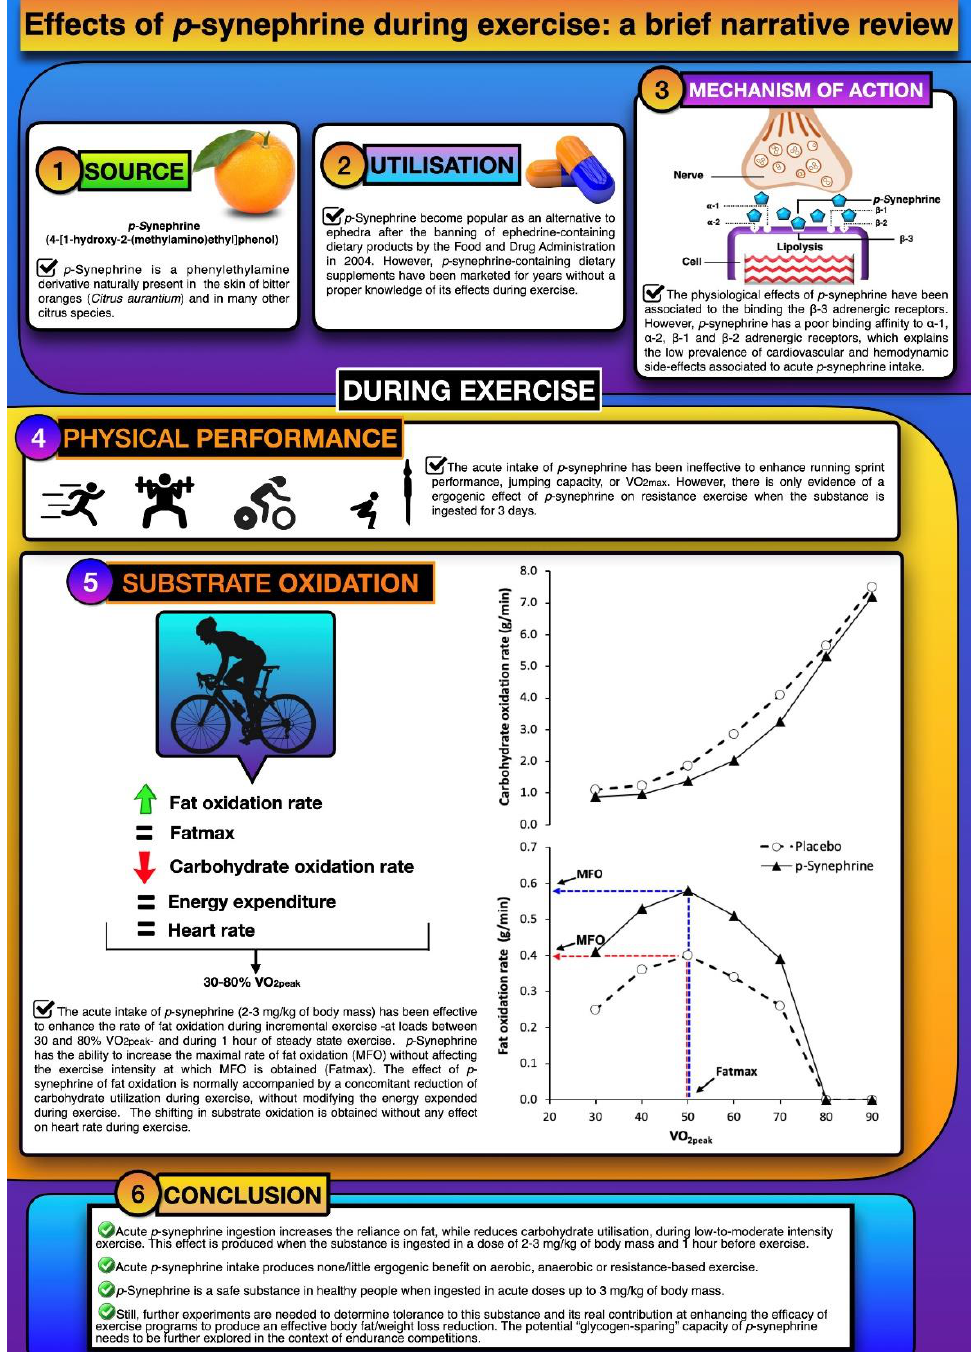
Figure 1. Infographic with a visual explanation of p -synephrine. The p -synephrine is a phenylethyl- amine derivative naturally present in the skin of bitter oranges ( Citrus aurantium ) and in many other citrus species. The p -synephrine became popular as an alternative to ephedra after the banning of ephedrine-containing dietary products by the Food and Drug Administration in 2004. The physio- logical effects of p -synephrine have been associated to the binding with the β -3 adrenergic receptors. During exercise the acute intake of p -synephrine has been ineffective to enhance performance. Acute intake of p -synephrine (2 – 3 mg/kg of body mass) has been effective to enhance the rate of fat oxida- tion during incremental exercise at loads and during 1 h of steady-state exercise. The p -synephrine has the ability to increase the maximal rate of fat oxidation without affecting the exercise intensity at which maximal fat oxidation (MFO)is obtained (i.e., Fatmax).